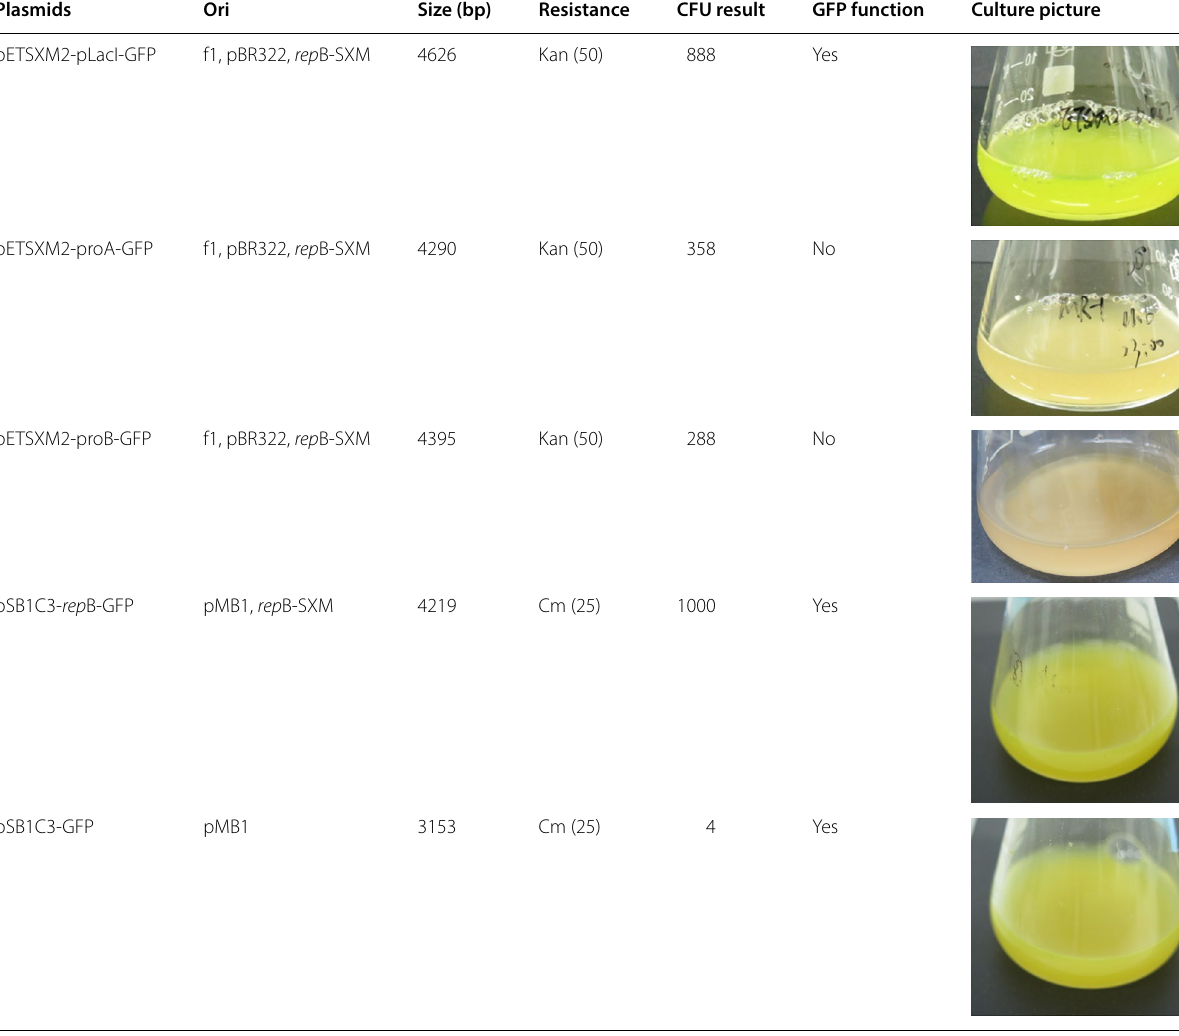
Table 2 Transformation of S. oneidensis MR-1 for over-expression of GFP with different ori and promoter